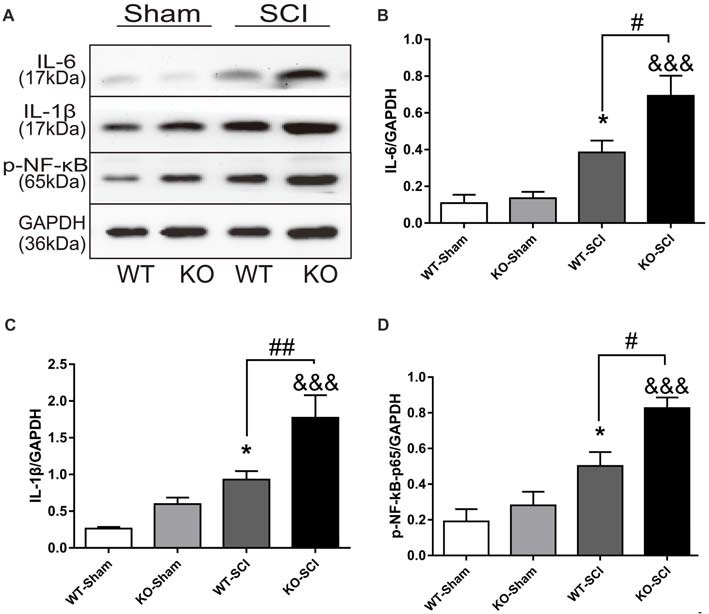
Apoe deficiency aggravates inflammatory response after SCI. (A) Representative WBs of inflammation-related proteins interleukin-6 (IL-6) and interleukin-1β (IL-1β), p-NF-κB and the loading control (GAPDH) in WT and Apoe KO groups at 7 days after SCI. (B–D) Quantitative analysis of IL-6, IL-1β and p-NF-κB expression. Data are expressed as mean ± SEM of three independent experiments (n = 6 per group). *p < 0.05, WT-Sham vs. WT-SCI, IL-6, p = 0.0459, IL-1β, p = 0.0465, p-NF-κB, p = 0.0223; &&&p < 0.001, KO-Sham vs. KO-SCI; IL-6, p < 0.001, IL-1β, p = 0.0002, p-NF-κB, p < 0.001; #p < 0.05, ##p < 0.01, WT-SCI vs. KO-SCI, IL-6, p = 0.0215, IL-1β, p = 0.0086, p-NF-κB, p = 0.0162, one-way ANOVA followed by Tukey’s post hoc test.